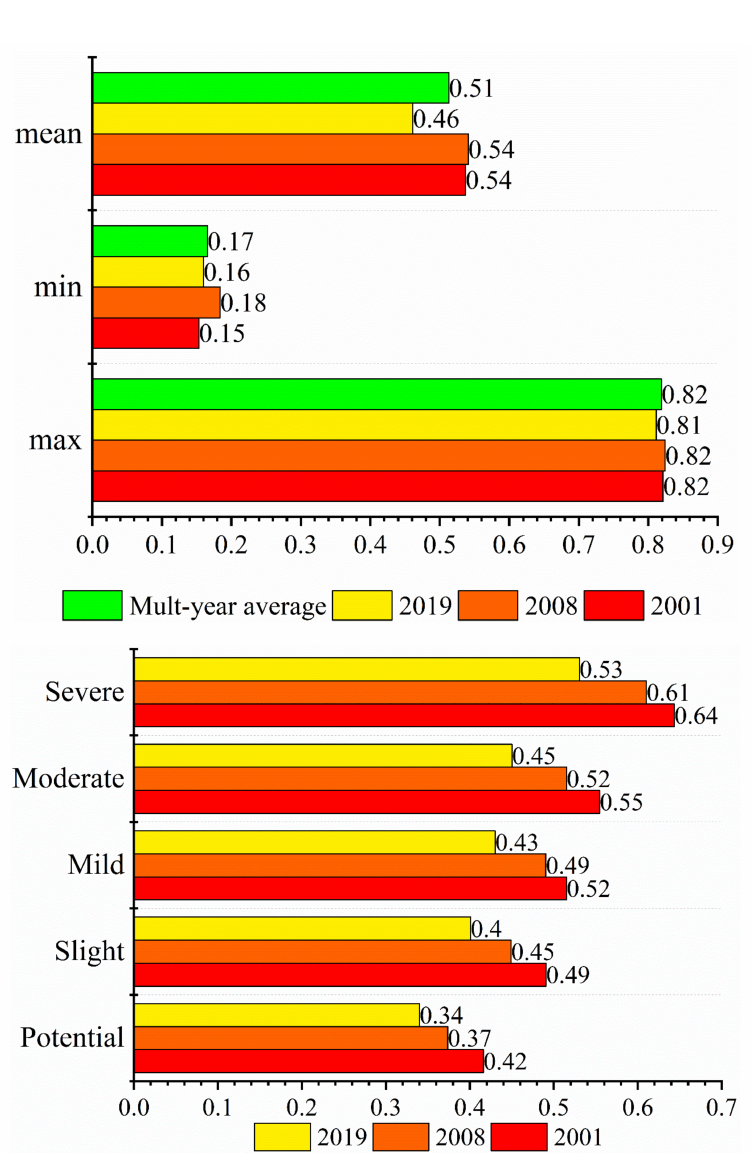
Figure 5. Histogram of minimum, maximum, and mean values based on EV in